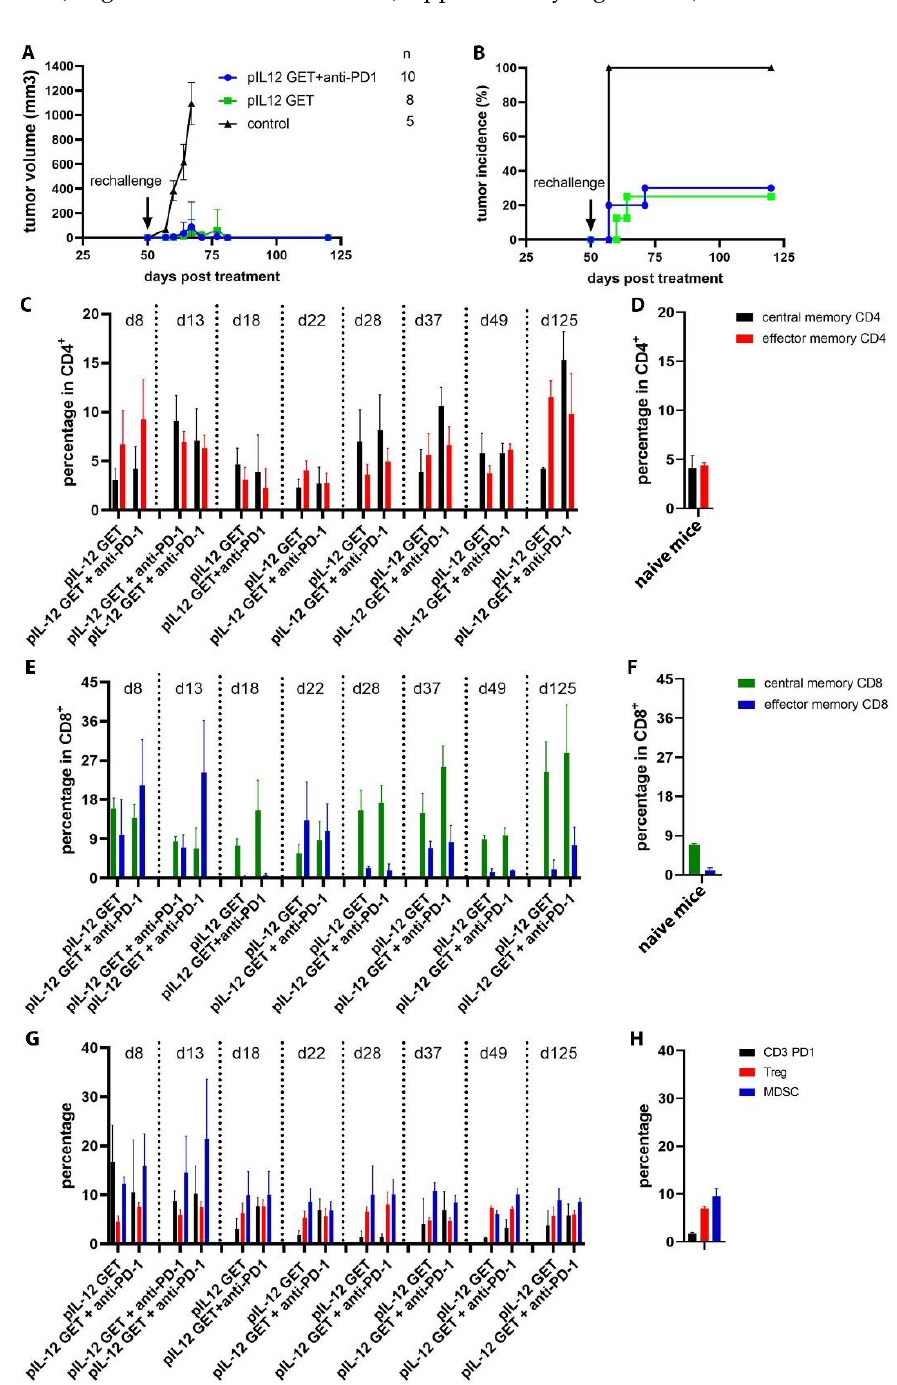
(Supplementary Figure S4C). Compared to PDL1 expression, H-2Kb is more susceptible to IFN- γ regulation at the same dose